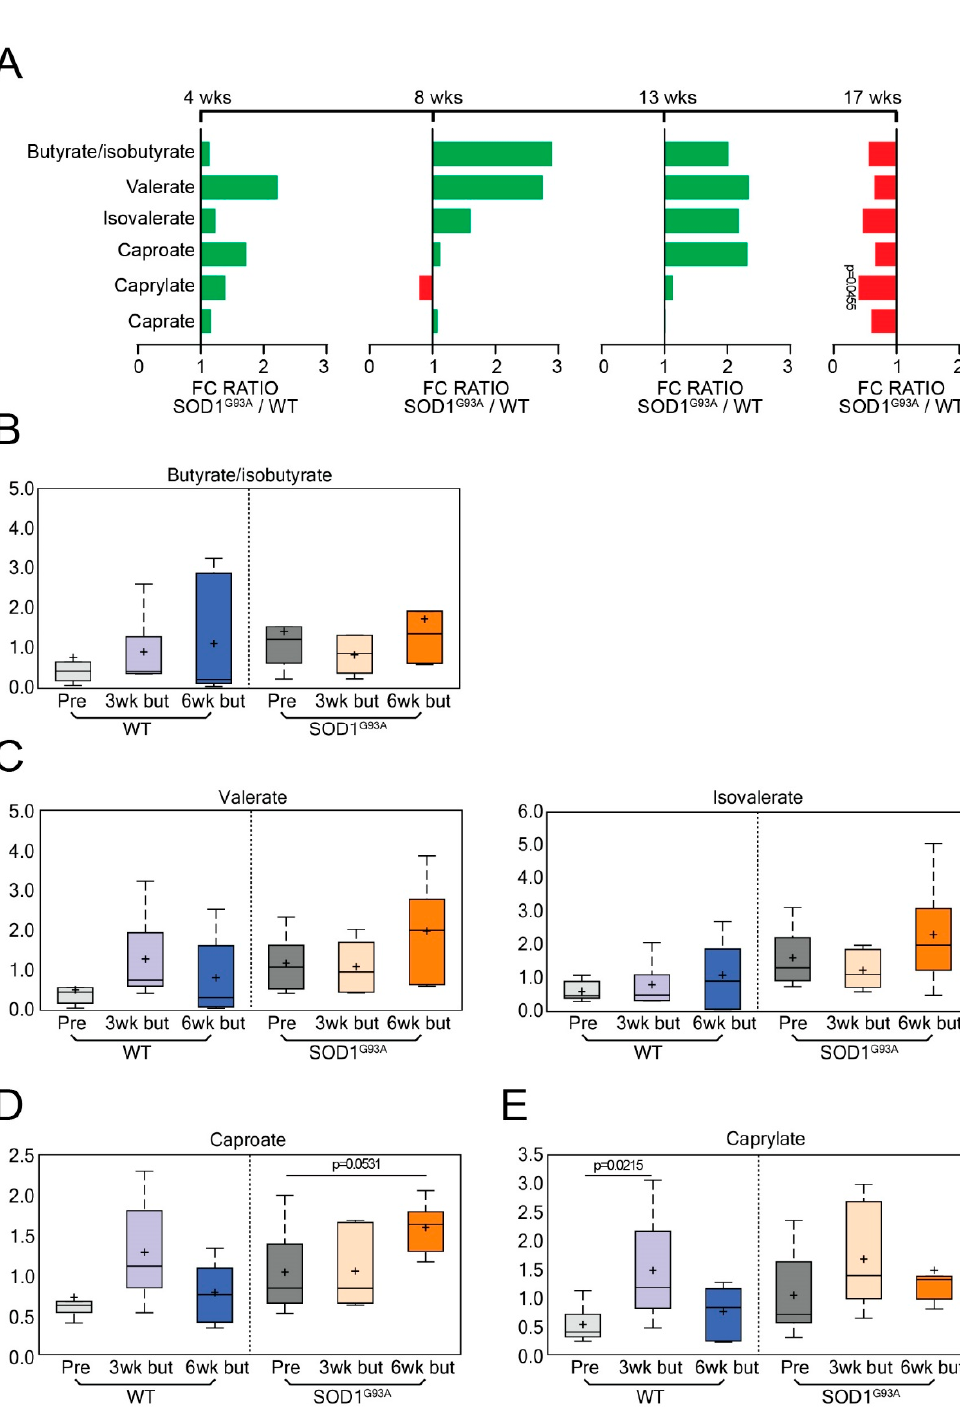
Figure 7. Fatty acid metabolites following butyrate administration in ALS. ( A ) Longitudinal changes of energy-related biochemicals in the WT and ALS mice over 17 weeks. The p -values for 4, 8, 13, and 17 weeks are labeled in the figures, and their corresponding q -values are provided in the figure legends. Caprylate (week 17: q = 0.9941). Box plot diagrams displaying longitudinal changes of butyrate-treated animals in ( B ) butyrate/isobutyrate; ( C ) valerate and isovalerate (at baseline: G93A vs. WT: p = 0.0111, q = 0.2687). ( D ) caproate (G93A: 6 weeks post-butyrate treatment vs. baseline, q = 0.1379; G93A vs. WT: 6 weeks post-butyrate treatment, p = 0.0145, q = 0.2617), and ( E ) caprylate (WT: 3 weeks post-butyrate treatment vs. baseline, q = 0.0520). Differences are assessed by the Welch’s two-sample t -test. For untreated groups: WT (N = 5) and SOD1 G93A (N = 5) mice. For treated groups: WT (N = 6) and SOD1 G93A (N = 6).